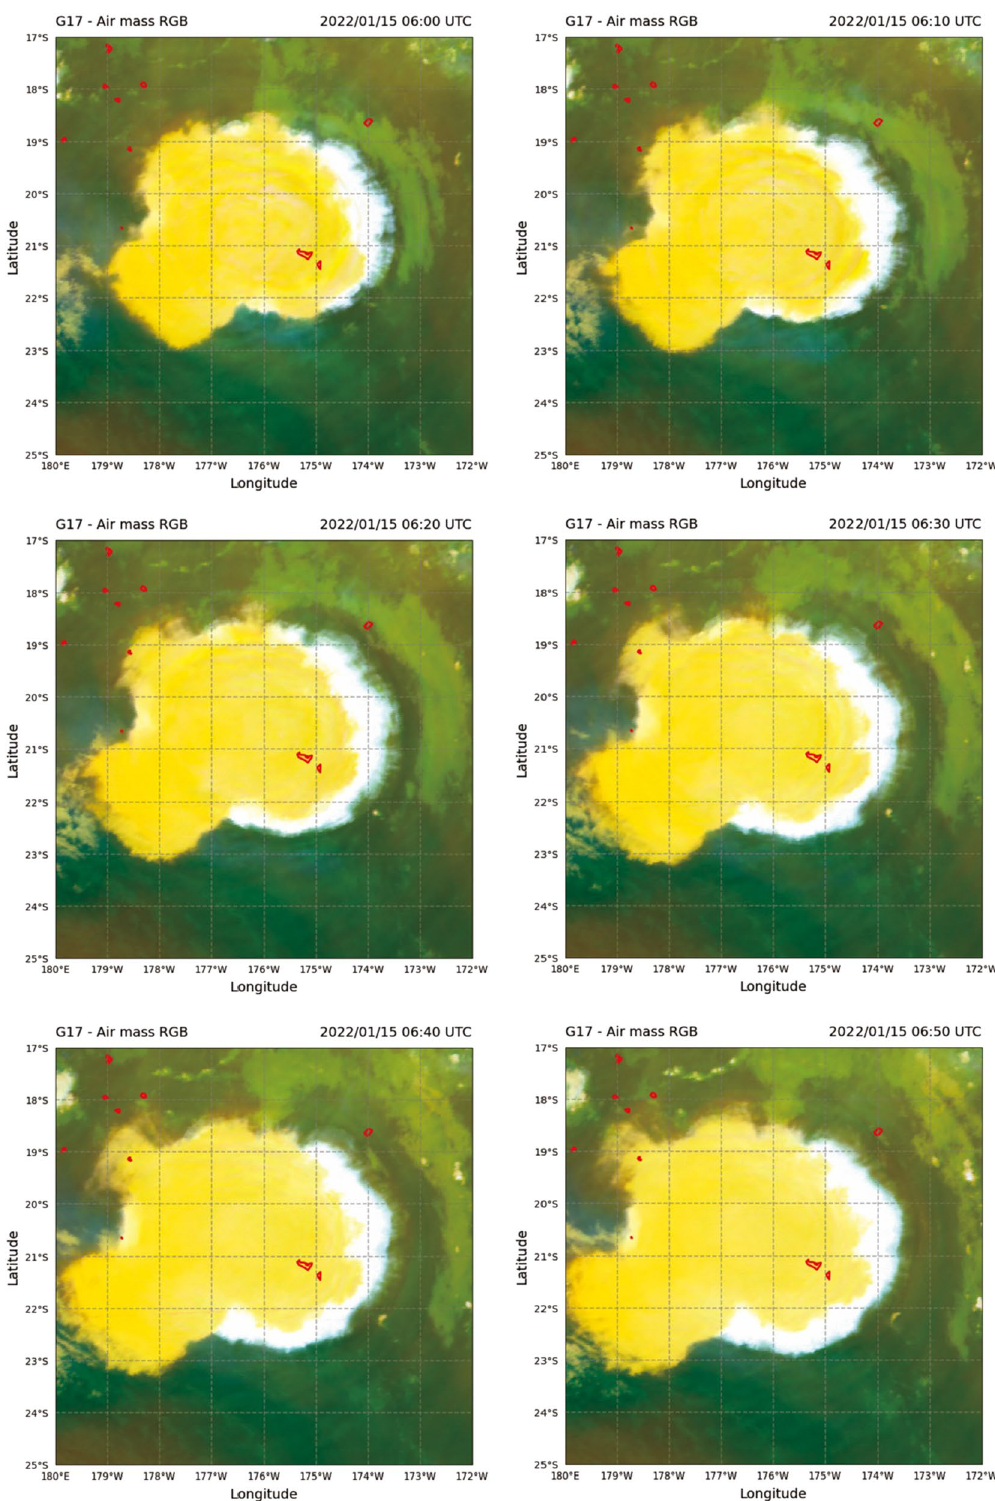
Fig. 15 Air mass RGB using GOES-17 from 06:00 to 06:50 on 15 January